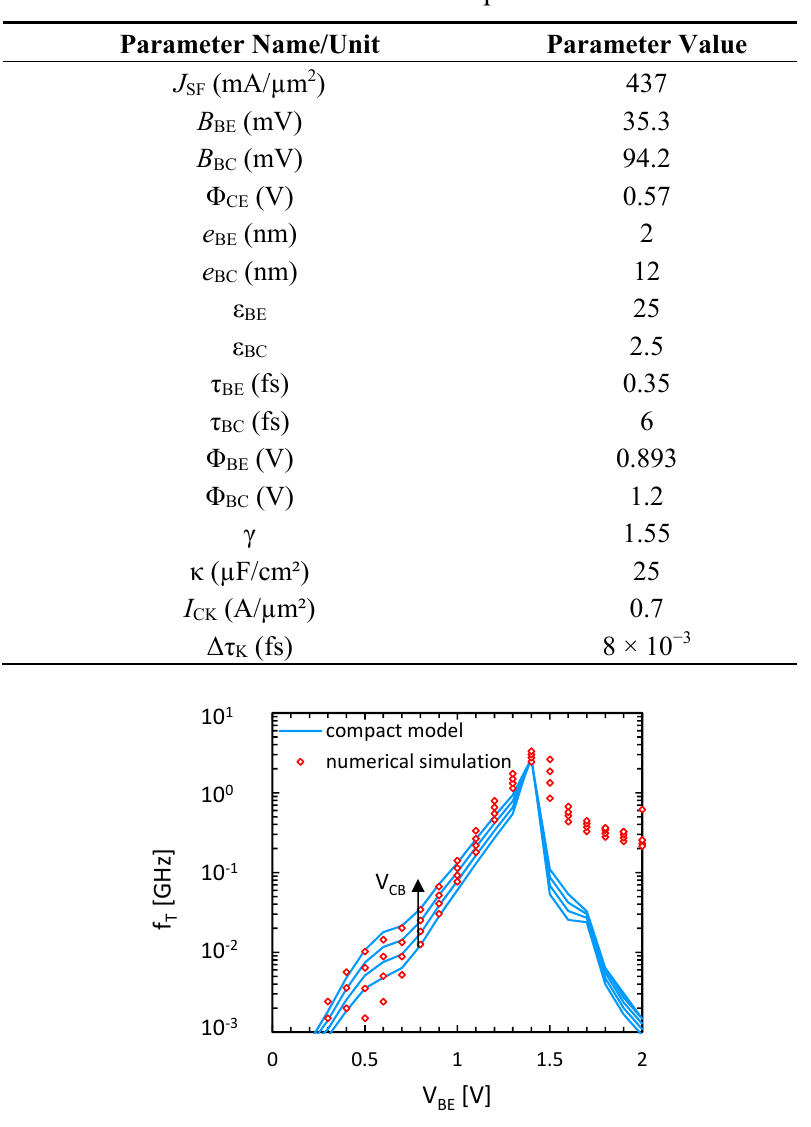
Figure 9. f T versus V BE curves for different V CB (2, 3, 4, 5 V), numerical simulation and compact model